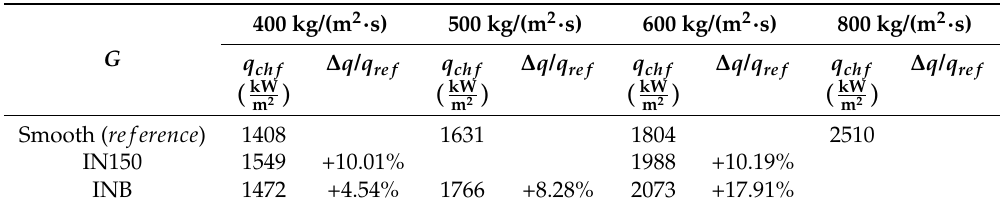
Table 11. CHF results of all investigated samples at 300